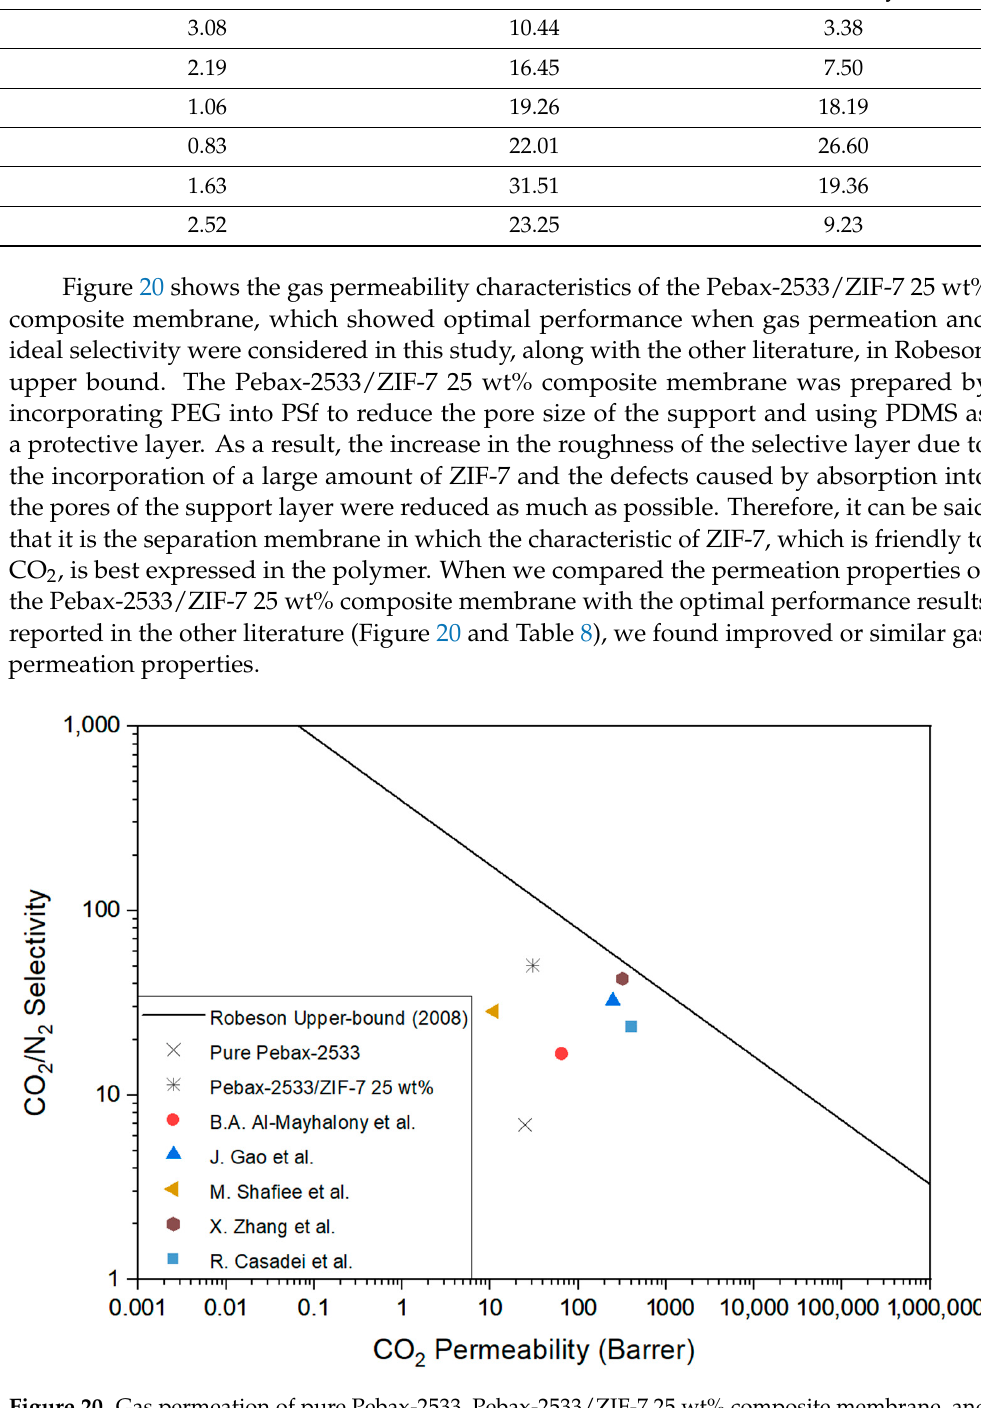
Table 7. Gas solubility properties of Pebax ‐ 2533/ZIF ‐ 7 composite membranes.